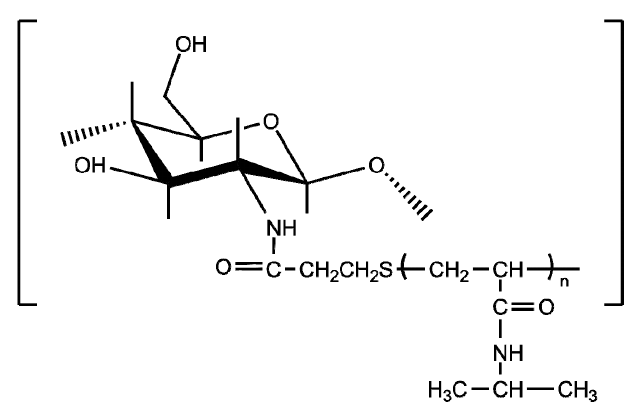
Figure 10. Chemical structure of chitosan- g -poly( N -isopropyl acrylamide).